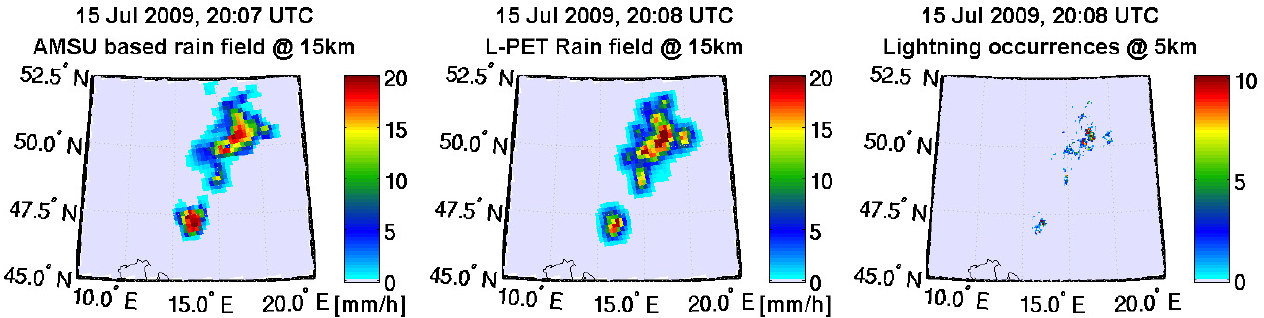
Fig. 9. Rain field provided by the AMSU-based algorithm applied to TB from MetOp-A satellite compared with contemporary rain field provided by L-PET algorithm and lightning occurrences used for the algorithm, over central Europe, 15 July 2009 at 20:07UTC.